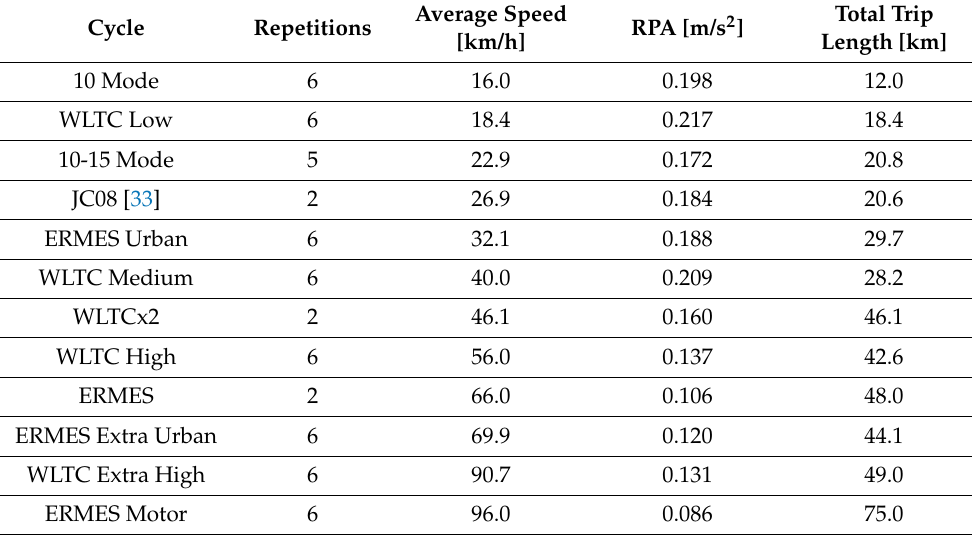
Table 4. Simulated Driving Cycles and